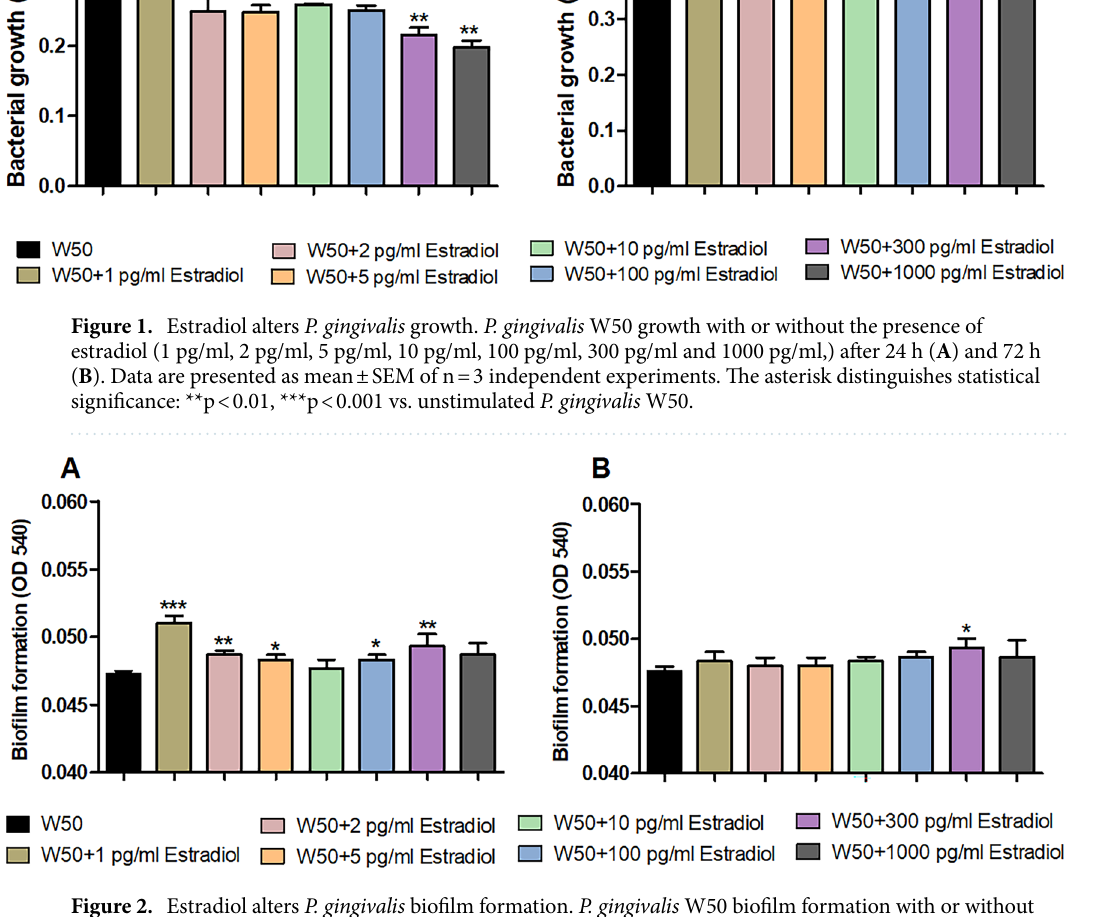
Figure 2. Estradiol alters P. gingivalis biofilm formation. P. gingivalis W50 biofilm formation with or without the presence of estradiol (1 pg/ml, 2 pg/ml, 5 pg/ml, 10 pg/ml, 100 pg/ml, 300 pg/ml and 1000 npg/ml,)